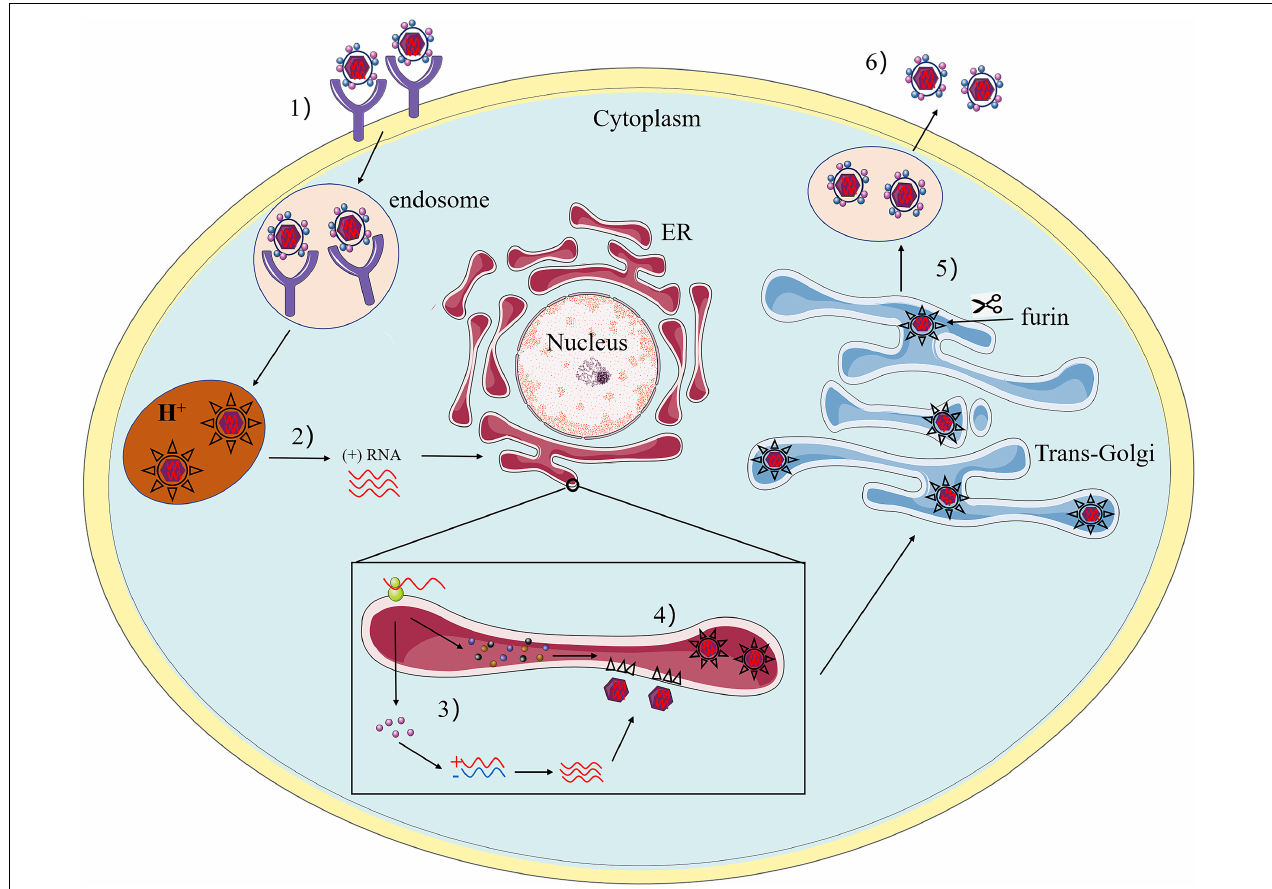
FIGURE 2 | The Flavivirus life cycle. (1) The viruses attach to the surface of a host cell and internalize by receptor-mediated endocytosis. (2) Acidification of the endosomal vesicle triggers conformational changes in the virion, fusion of the viral envelope and cell membranes, releasing the viral genome into the cytoplasm. (3) The positive-sense RNA is translated into a single polyprotein that is processed co- and post-translationally by viral and host proteases. The viral RNA-dependent RNA polymerase replicates the viral genome in specialized ER-derived membrane compartments. (4) Virus assembly occurs on the surface of the ER, the immature viral particles bearing prM and E bud into ER rumen after nucleocapsid formation with viral RNA. The resultant non-infectious, immature viral are transported to the trans-Golgi network (TGN). (5) The host protease furin cleaved of prM to M, generating mature infectious particles. (6) Mature virions are subsequently released by